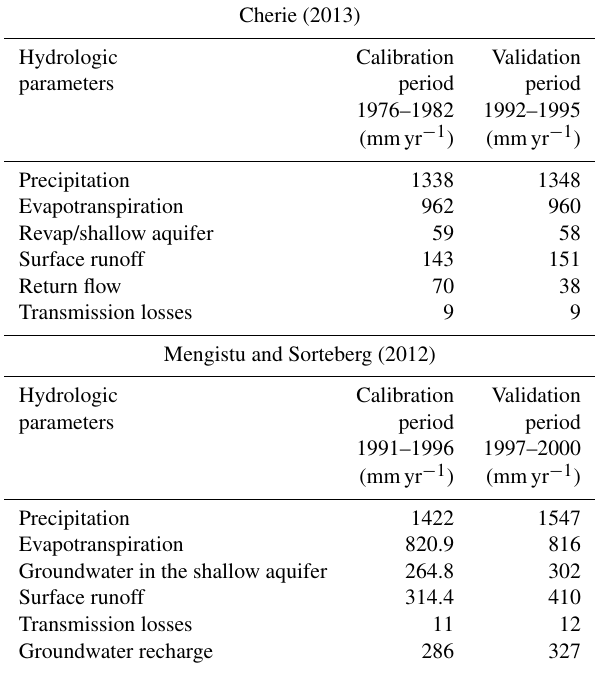
Table 1. Average annual water balance components in the upper Blue Nile Basin based on different